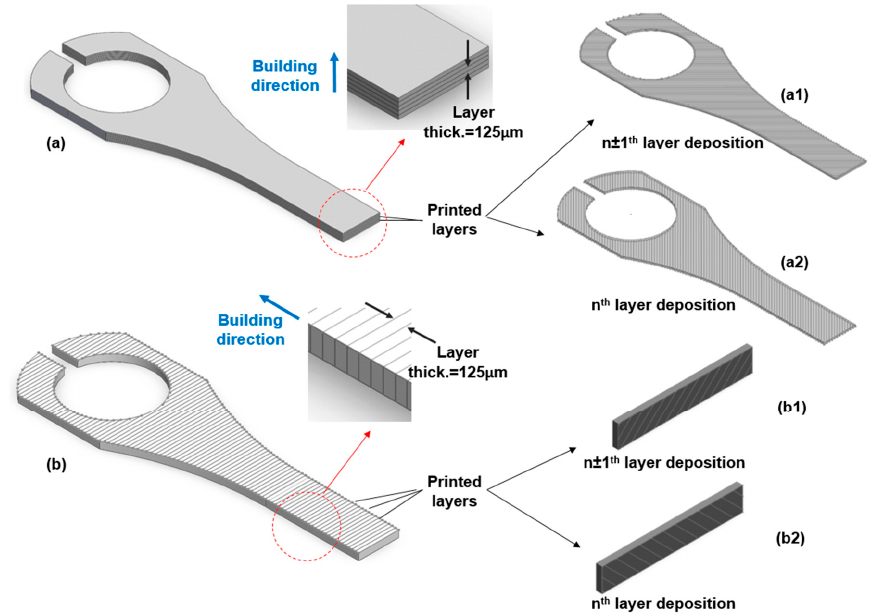
Figure 13. Schematic solid infill printing pattern of n th and ( n ± 1) th layers for H ( a , a1 , a2 ) and V ( b , b1 , b2 ) ultrasonic bending fatigue test specimens. The metal powders bond together during the sintering process to produce a solid part, but voids remain in the layer interfacial and track boundary regions, forming layer